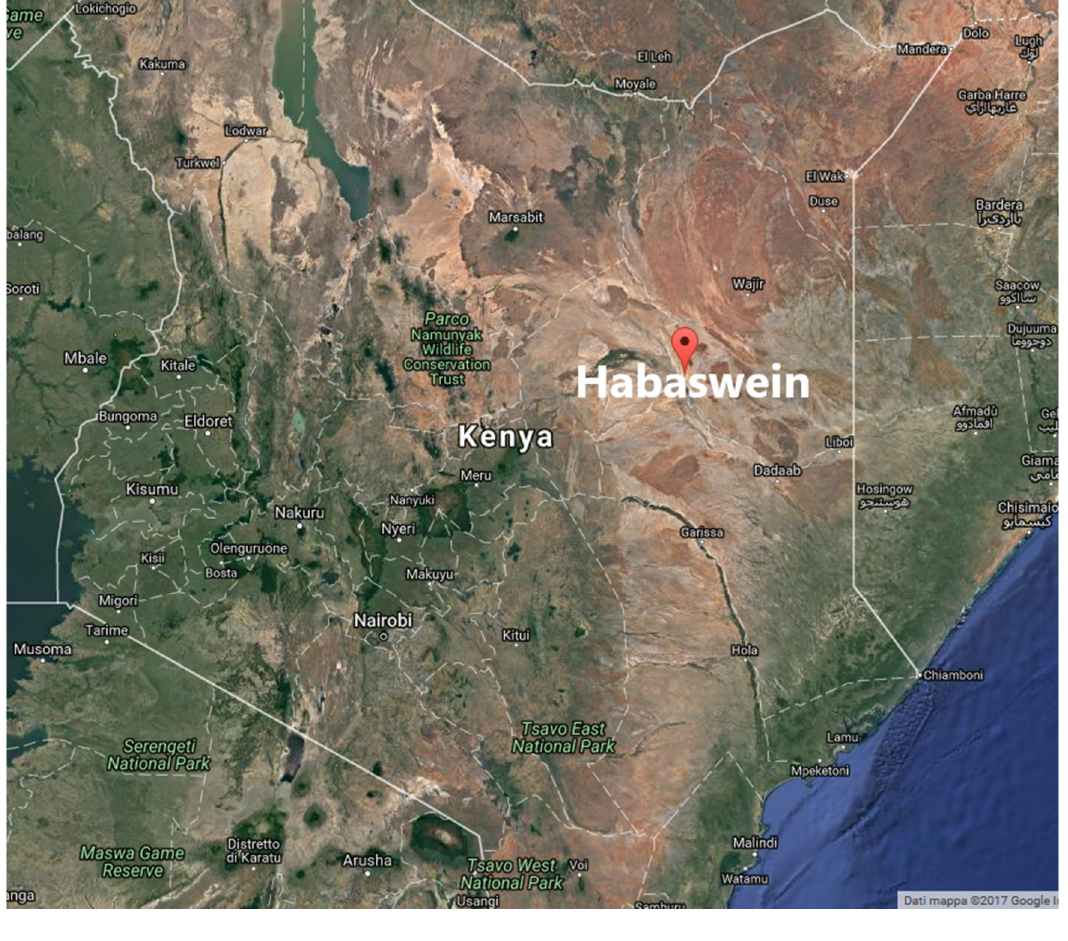
Figure 1. Habaswein location.